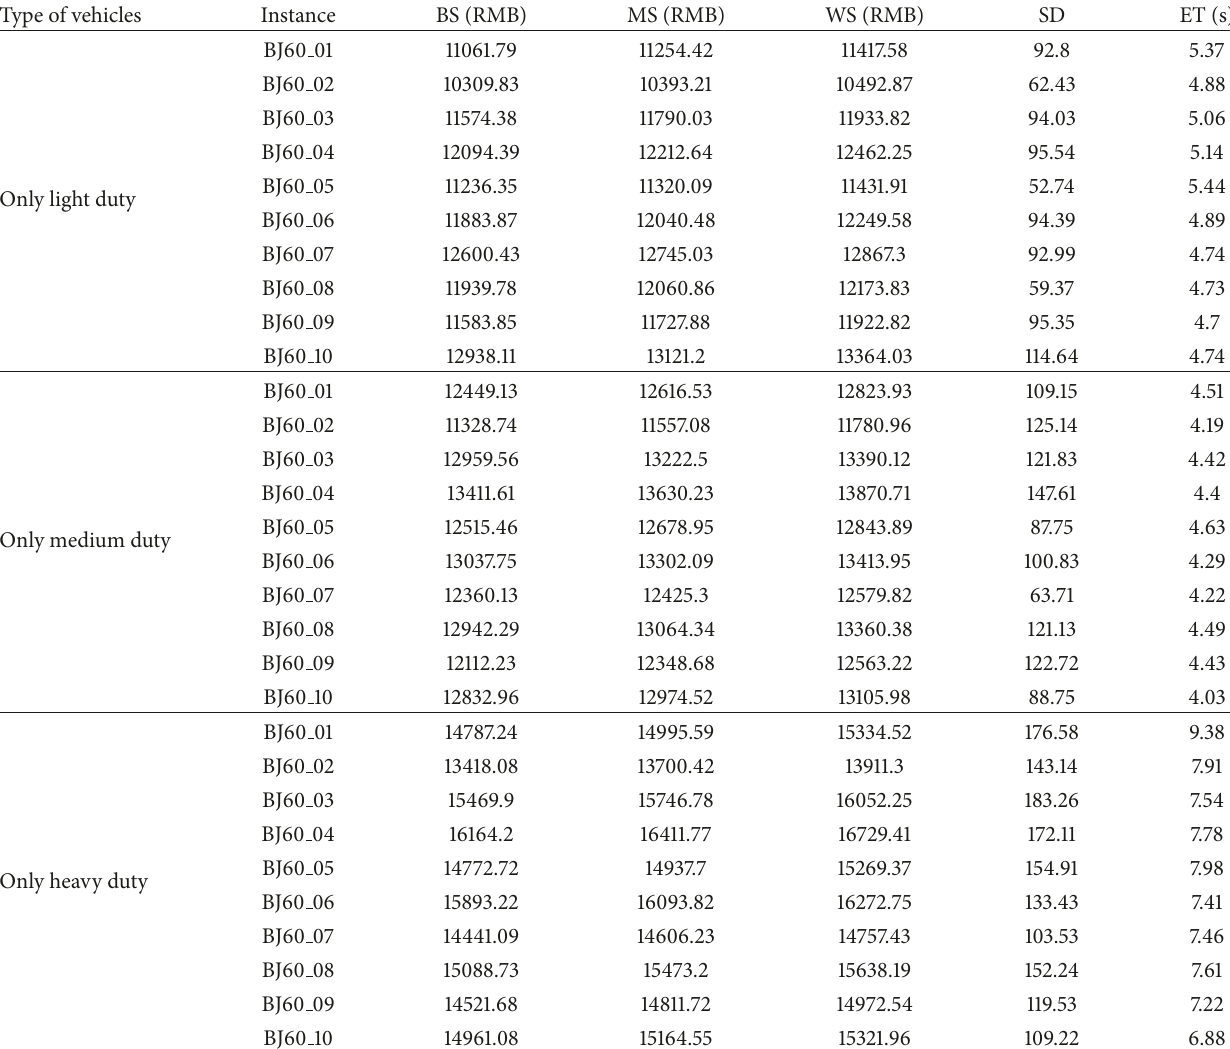
Table 11: Computational results on the 60-node instances by using different vehicles.